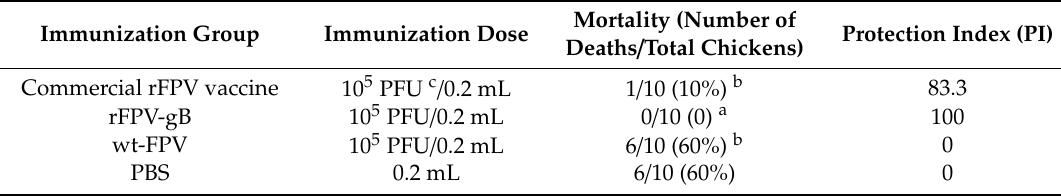
Table 4. Protective e ffi cacy induced by rFPVs in SPF chickens.